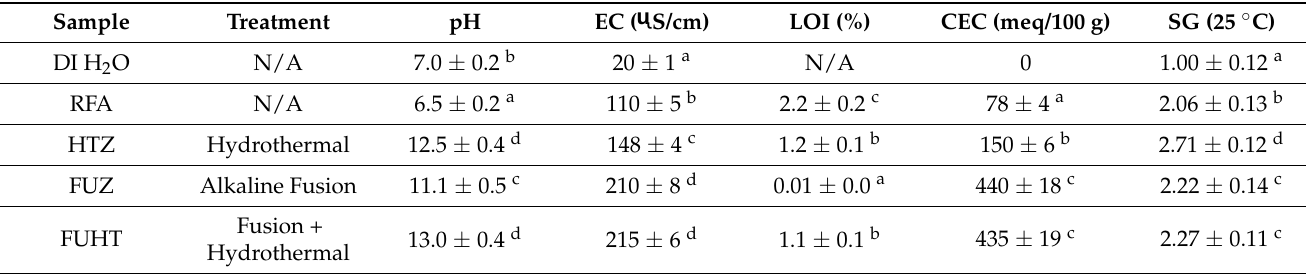
Table 1. Physicochemical properties of supernatant/material of RFA and Na-zeolites. Sample